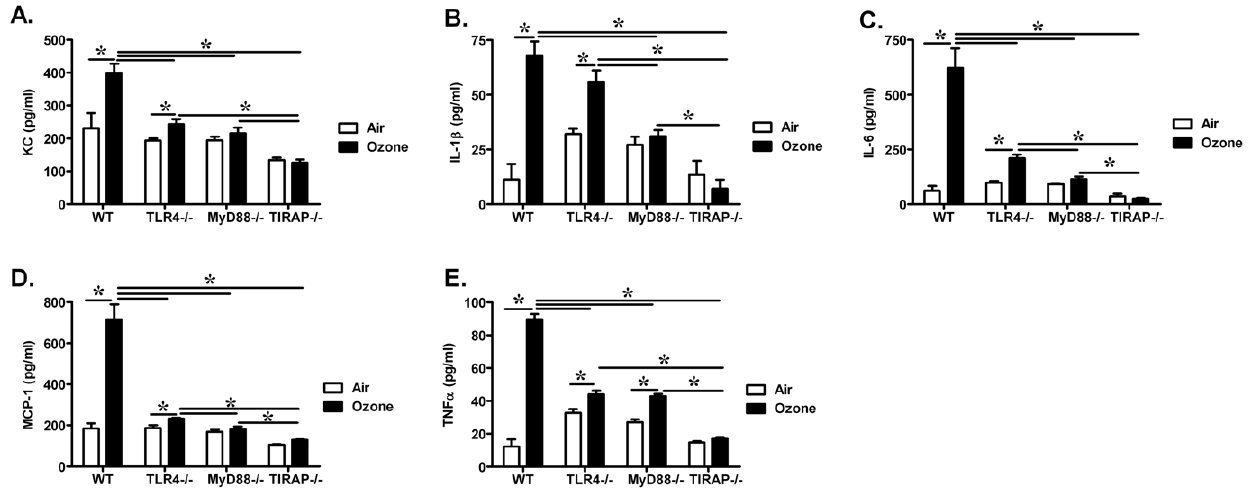
Figure 3. Ozone inhalation increased the level of pro-inflammatory factors in alveolar lavage fluid in a manner partially dependent on TLR4, MyD88, and TIRAP. The level of ( A ) KC, ( B ) IL-1 b , ( C ) IL-6, ( D ) MCP-1 and ( E ) TNF a in BALF from air and ozone-exposed WT, TLR4 2 / 2 , MyD88 2 / 2 and TIRAP 2 / 2 mice were measured by luminex beads (*p , 0.05, vs. FA exposed group; # p , 0.05, vs. O 3 -exposed group comparisons between strains; N=4–5 per group).